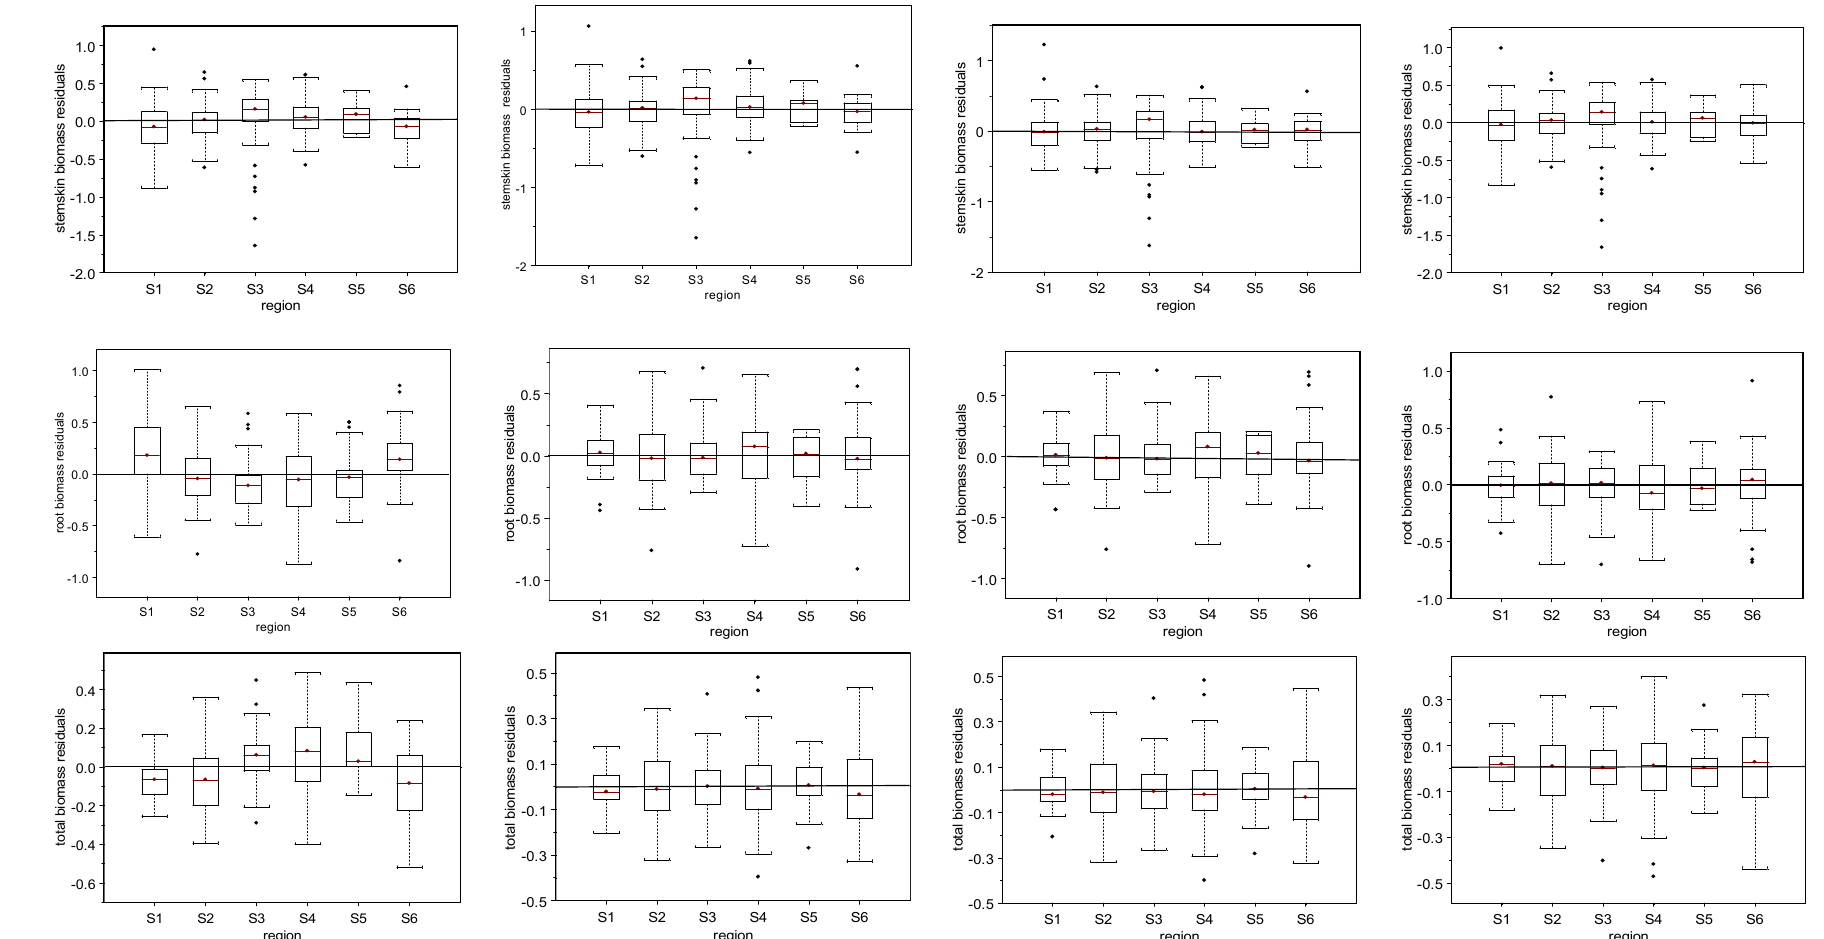
Figure 2. Residual boxplots of the biomass component of all models ( A – D ) represent the general biomass model, linear mixed effects model, the dummy variable model, and the Bayesian hierarchical model respectively).